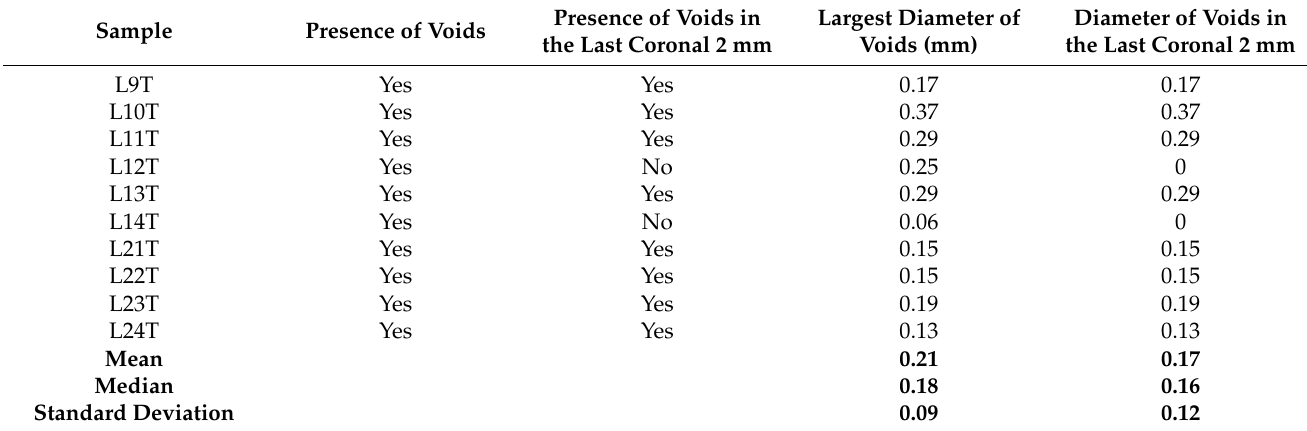
Table 7. Voids detected in the study group.